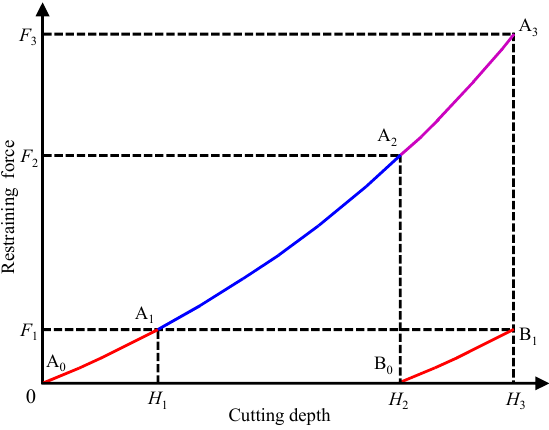
Figure 1. Variation curve of the restraining force with cutting depth.